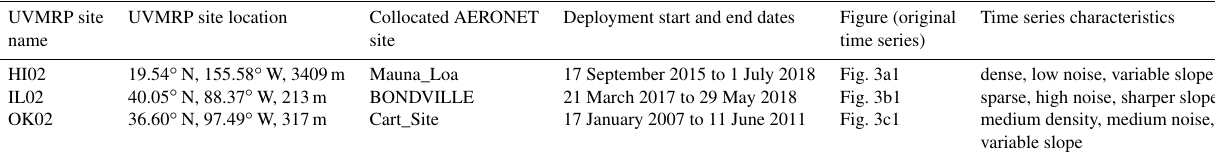
Table 1. The three UVMRP 368nm UV-MFRSR in situ calibration factor time series for